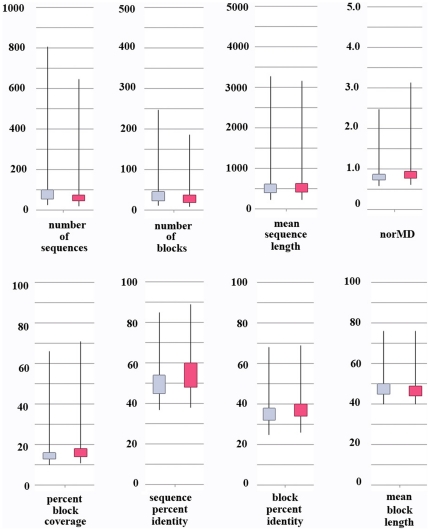
General statistics computed for the benchmark alignments.In the box-and-whisker plots, boxes indicate lower and upper quartiles, and whiskers represent minimum and maximum values. Blue boxes correspond to the alignment of all sequences. Red boxes correspond to the alignments containing only reliable sequences, with no identified sequence discrepancies.